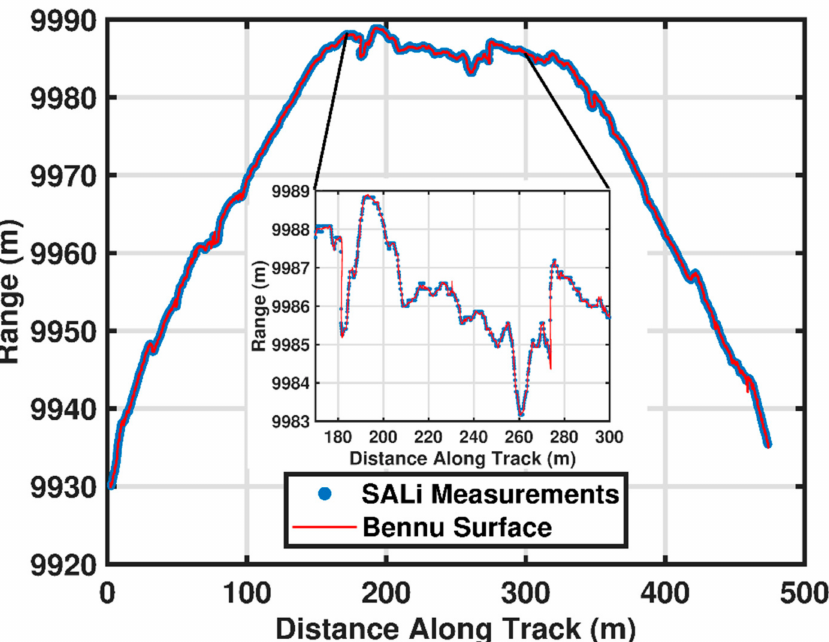
Figure 14. Range from the spacecraft altitude to the Bennu surface and the retrieved range from the SALi performance simulation as a function of distance along track. Each blue marker represents one 10-ms measurement. The red line was generated from the interpolated ground track elevation. (inset) A portion of the track from 170 m to 300 m showing the range measurements tracking the elevation over sharp features in the surface terrain.